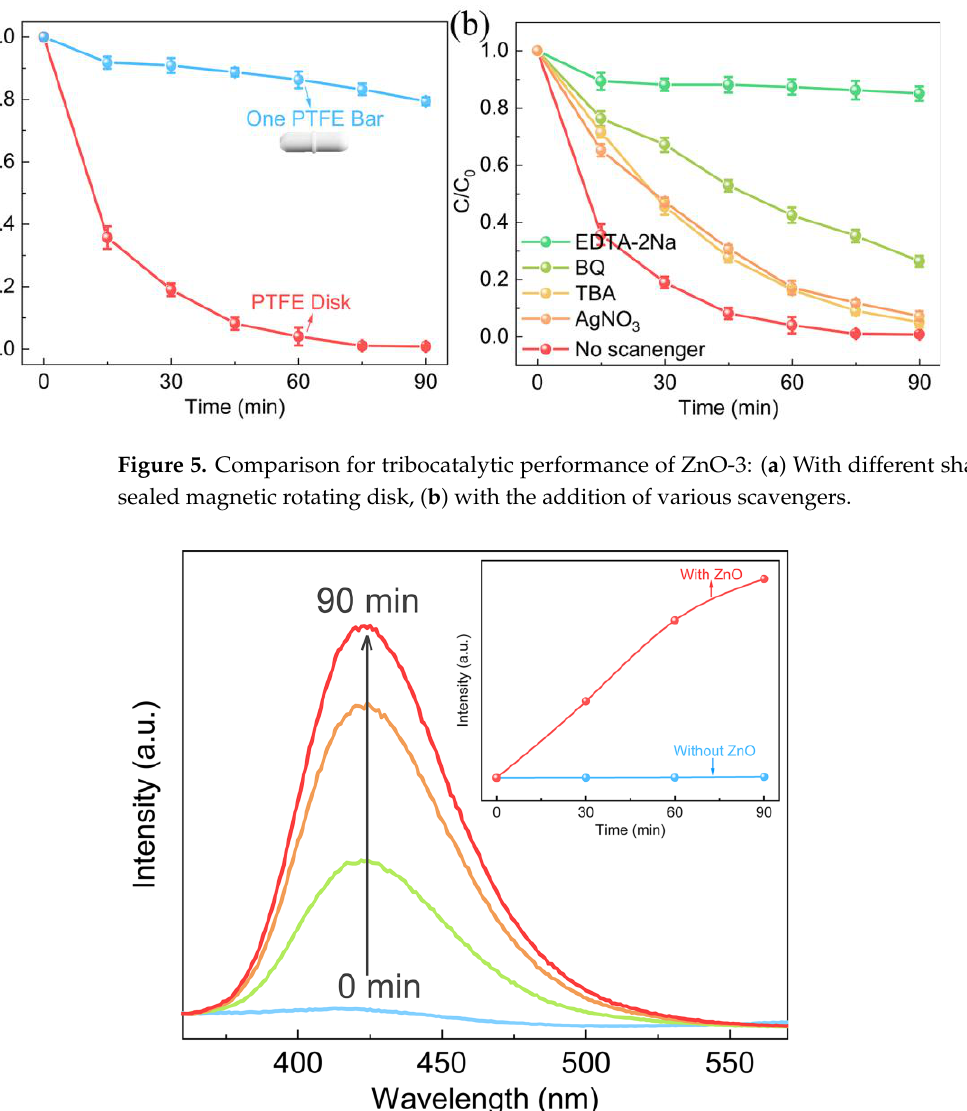
Figure 6. Fluorescence spectrum of 2-hydroxytereohthalic acid for ·OH detection under stirring for 90 min (Inset: The max intensity of 2-hydroxytereohthalic acid at 425 nm).